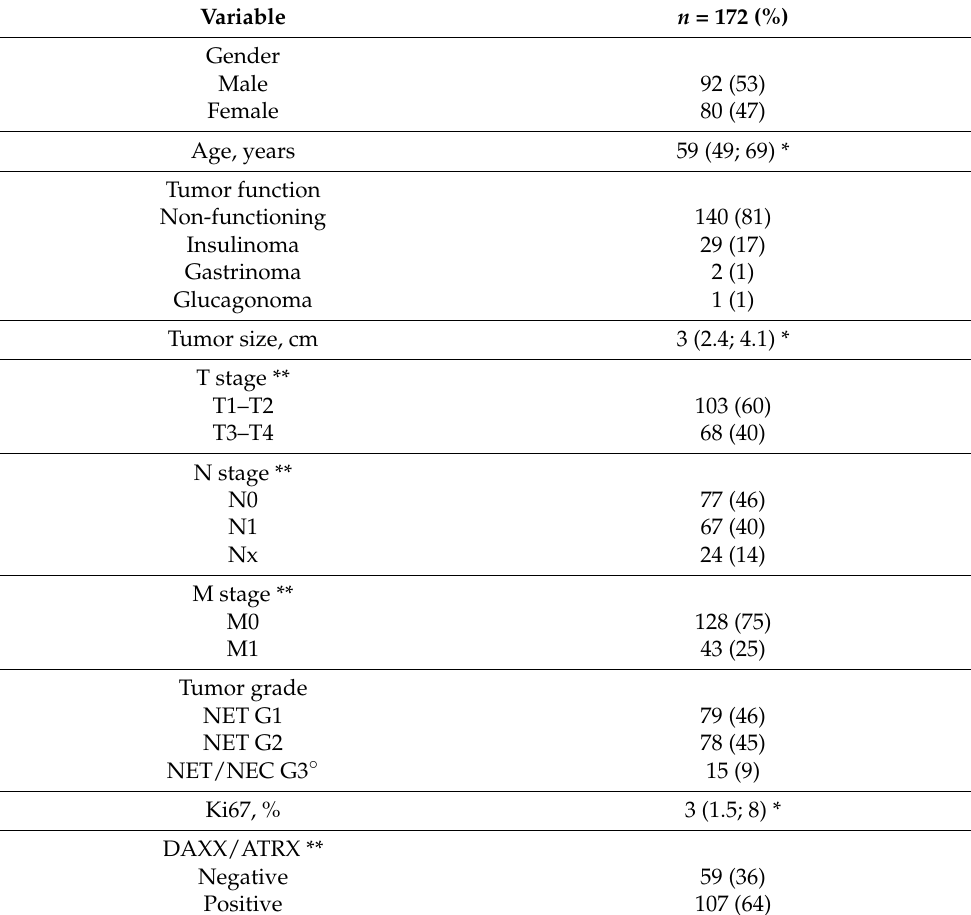
Table 1. Clinico-pathological features of patients submitted to surgery for pancreatic neuroendocrine neoplasms